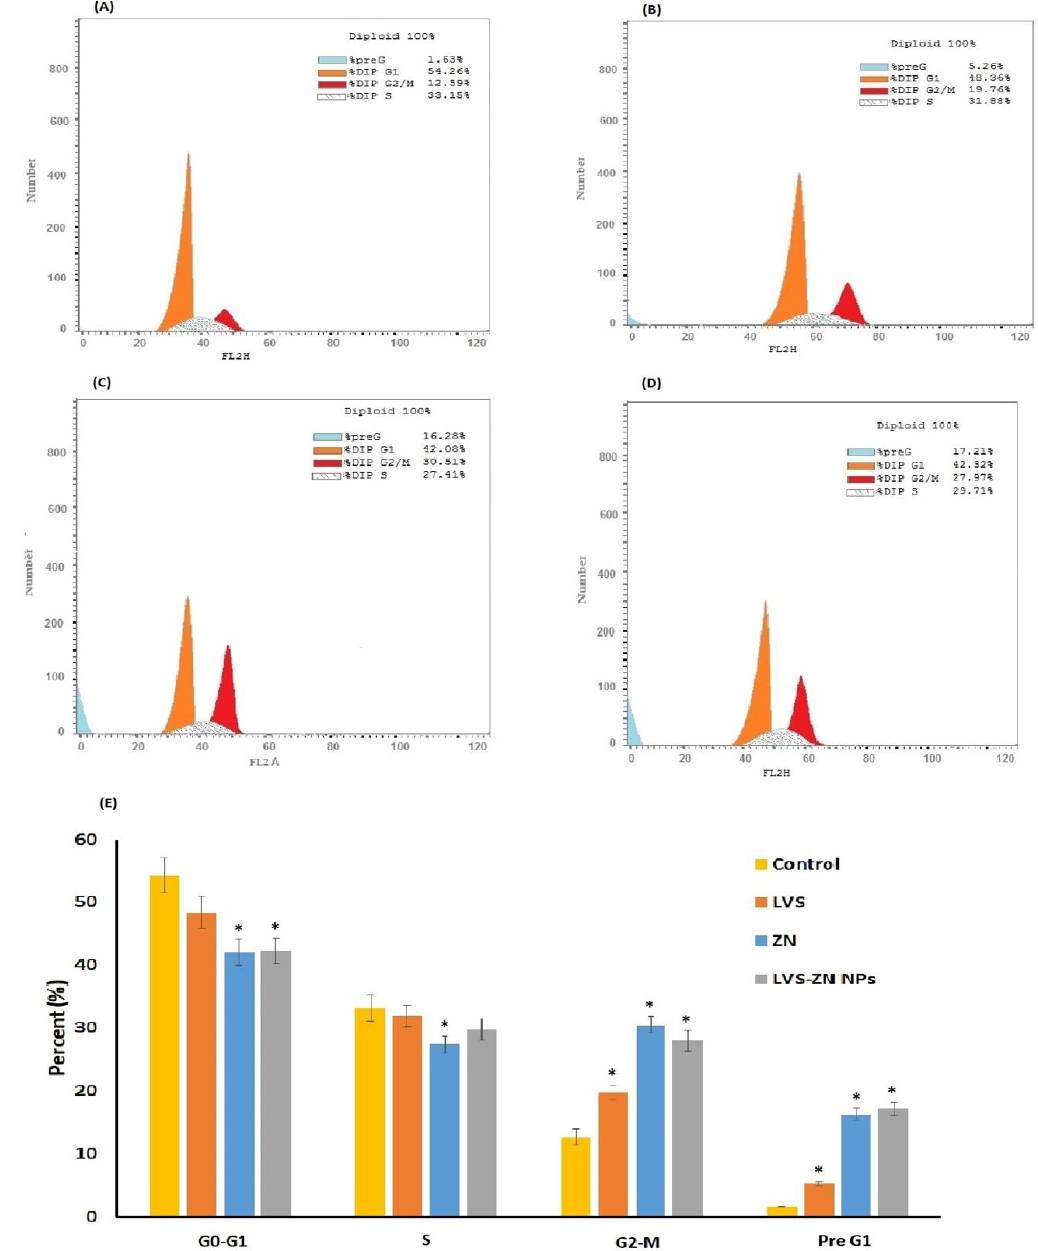
Figure 6. Impact of the LVS-ZN NPs on the cell cycle phases. ( A ) Control, ( B ) raw LVS, ( C ) Zn, ( D ) LVS-ZN NPs, and ( E ) graphical presentation of each phase. * Significantly different ( p < 0.05) compared to the corresponding control.